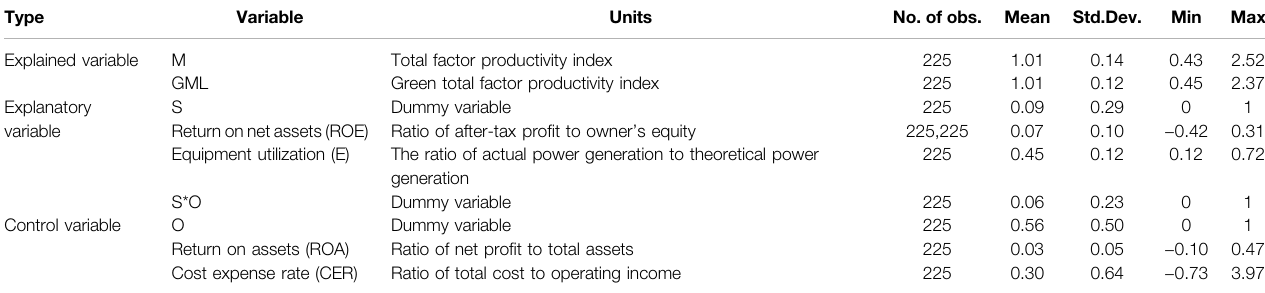
TABLE 6 | Description of the main variables and their descriptive statistical